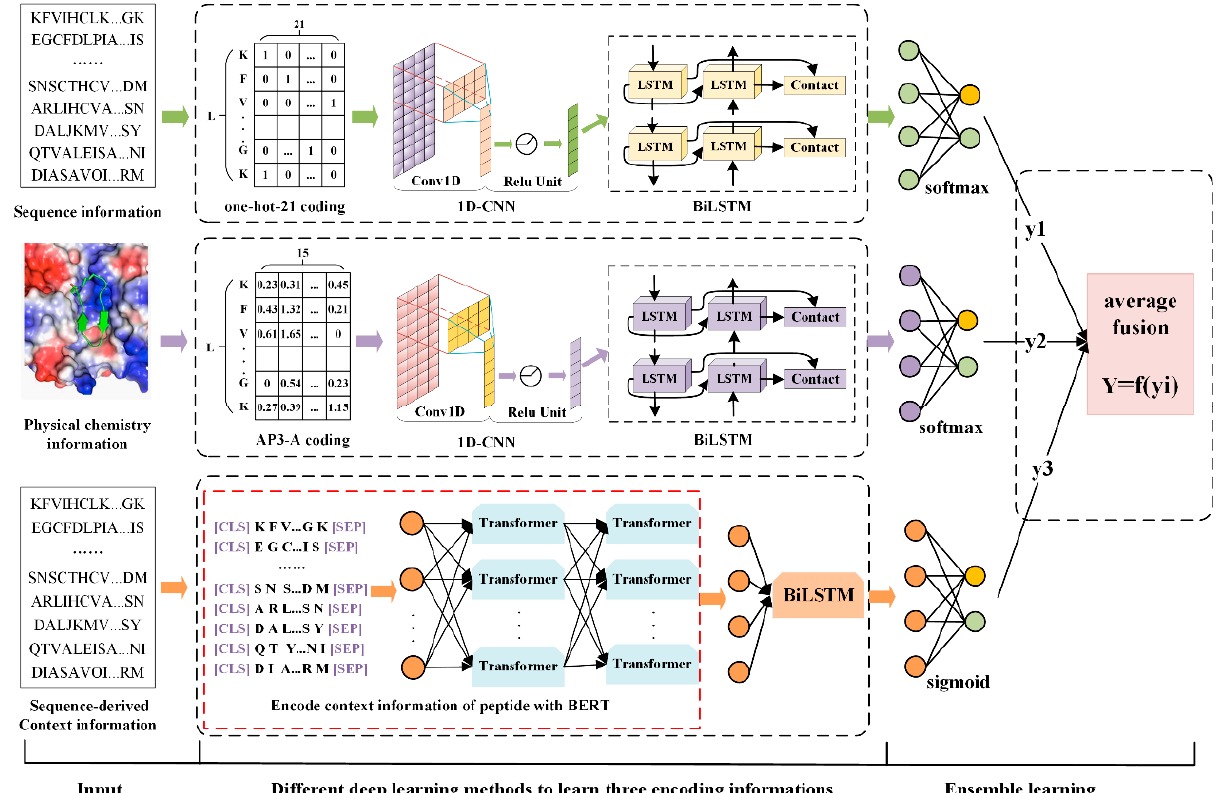
Figure 4. The architecture of PD-BertEDL.